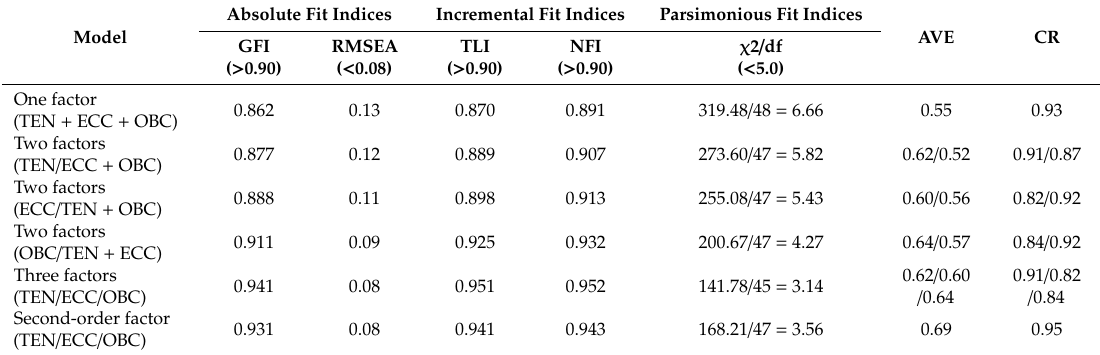
Table 2. Results of the confirmatory factor analysis for the high-quality interpersonal relationship